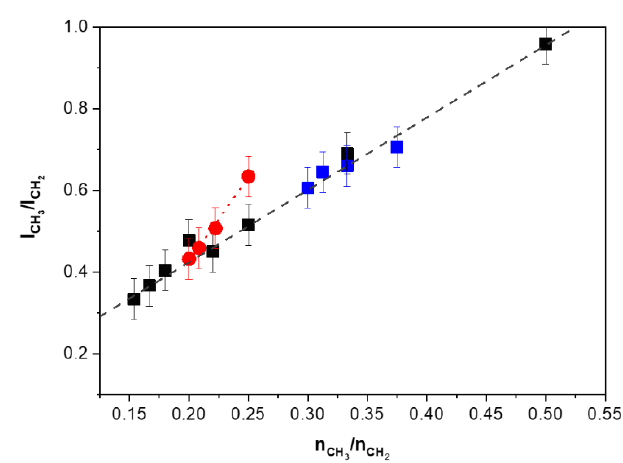
Figure 12. The ratio 𝐼 (cid:3004)(cid:3009) versus the relative content 𝑛 (cid:3004)(cid:3009) of CH 3 and CH 2 units for the hydrogenated 1-hexene oligomers ( ■ ), 1-octene oligomers ( ● ), and linear alkanes ( ■ ). Symbols ■ , ● , ■ are the experimental data; dark grey and red dash lines are the linear functions (4) and (5), respectively. The measurement errors of the intensity ratio are also indicated.